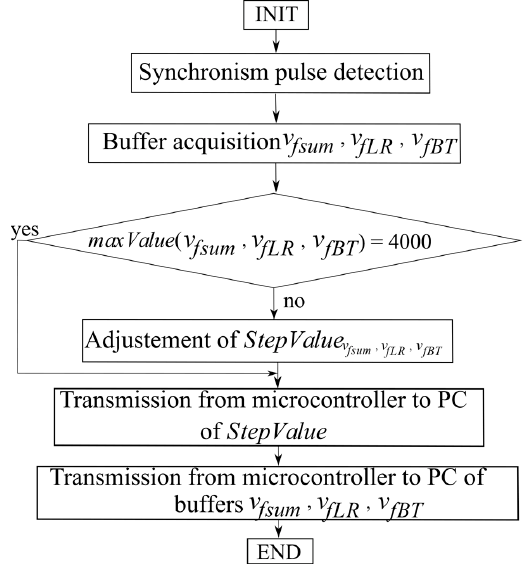
Figure 6. Flowchart of the acquisition process at the receiver.